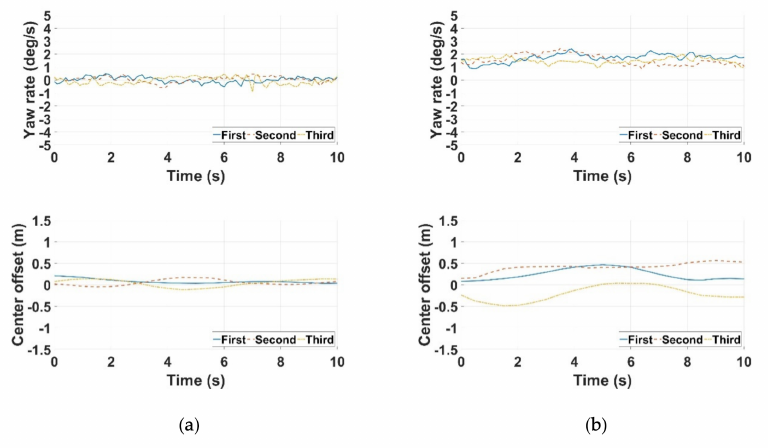
Figure 7. Yaw rate and distance to the center of the lane: ( a ) scenario 1 and ( b ) scenario